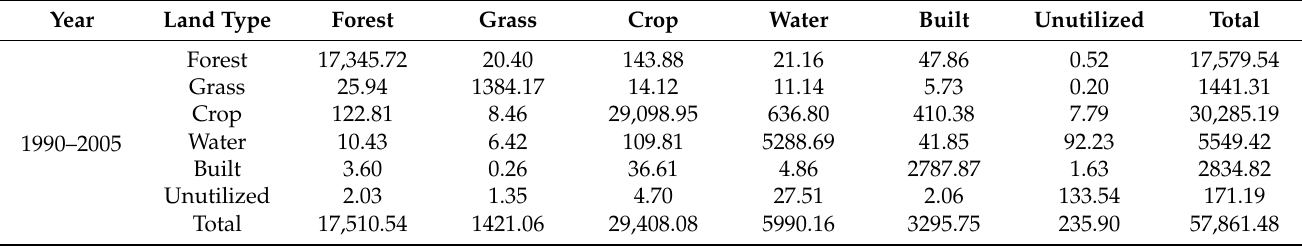
Table 3. Land use type transfer matrix of Wuhan metropolitan area from 1990 to